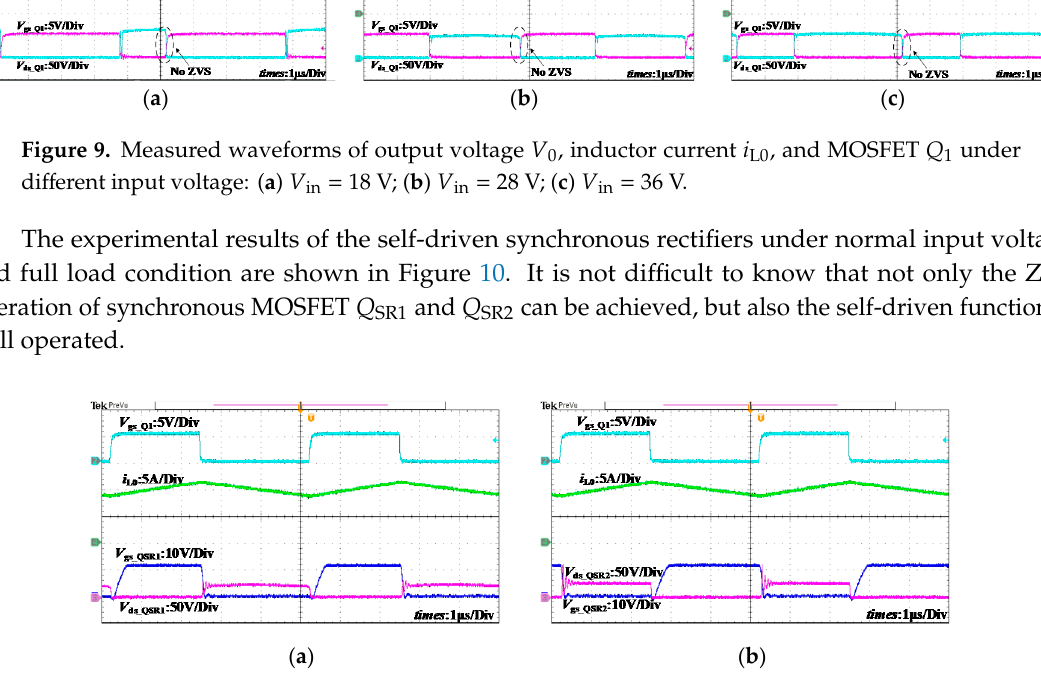
Figure 10. Experimental waveforms of Q SR 1 and Q SR 2 under input voltage of 28 V: ( a ) Q SR1 and i L0 ; ( b ) Q SR2 and i L0 .